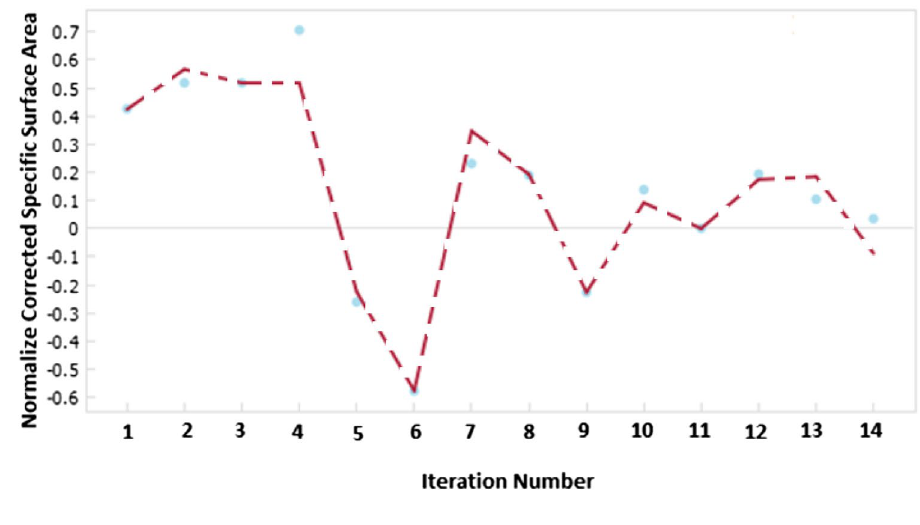
Table 12 Normalized corrected specific surface area, porosity and permeability of selected chips